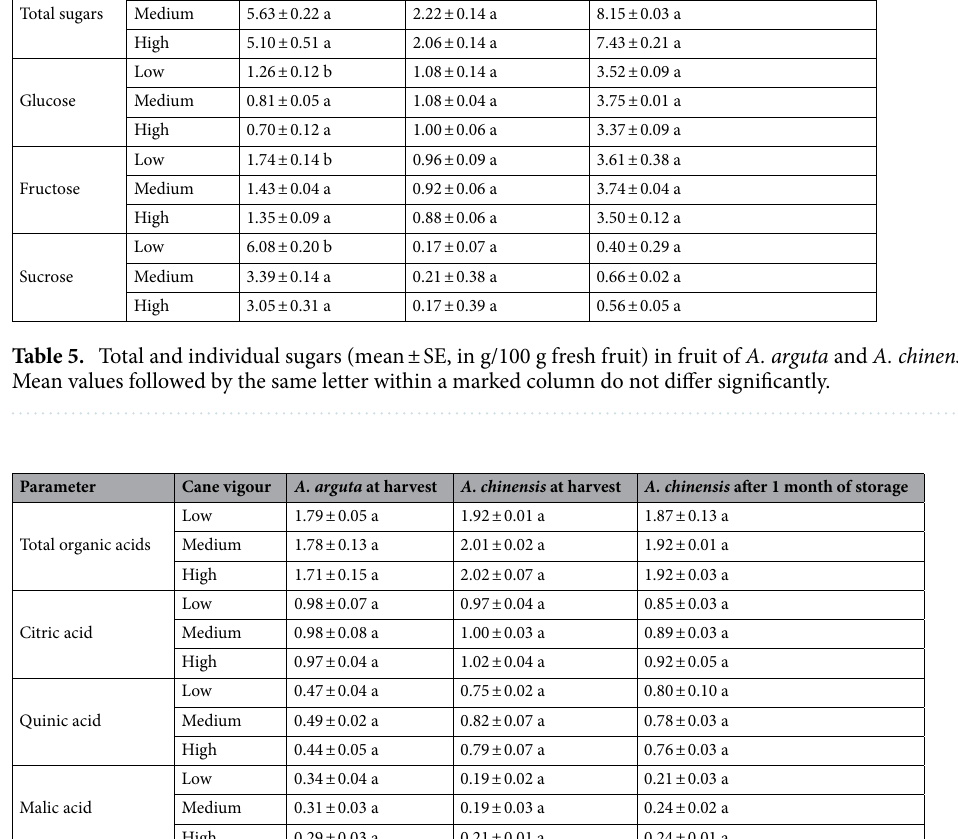
Table 6. Total and individual organic acids (mean ± SE, in g/100 g fresh fruit) in fruit of A. arguta and A. chinensis . Mean values followed by the same letter within a marked column do not differ significantly.